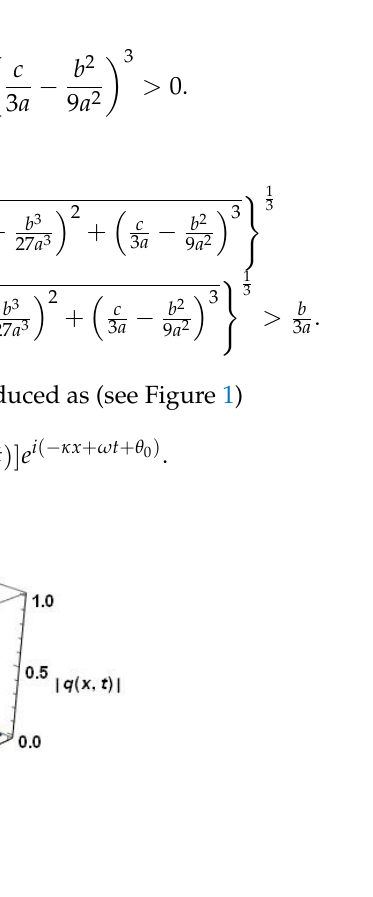
Figure 1. Profile of the HD bright 1–soliton (41) setting all arbitrary parameters to unity. Here, the inverse width ( B ) is explicitly expressed via (37), provided that the constraint conditions given by (38)–(40) are